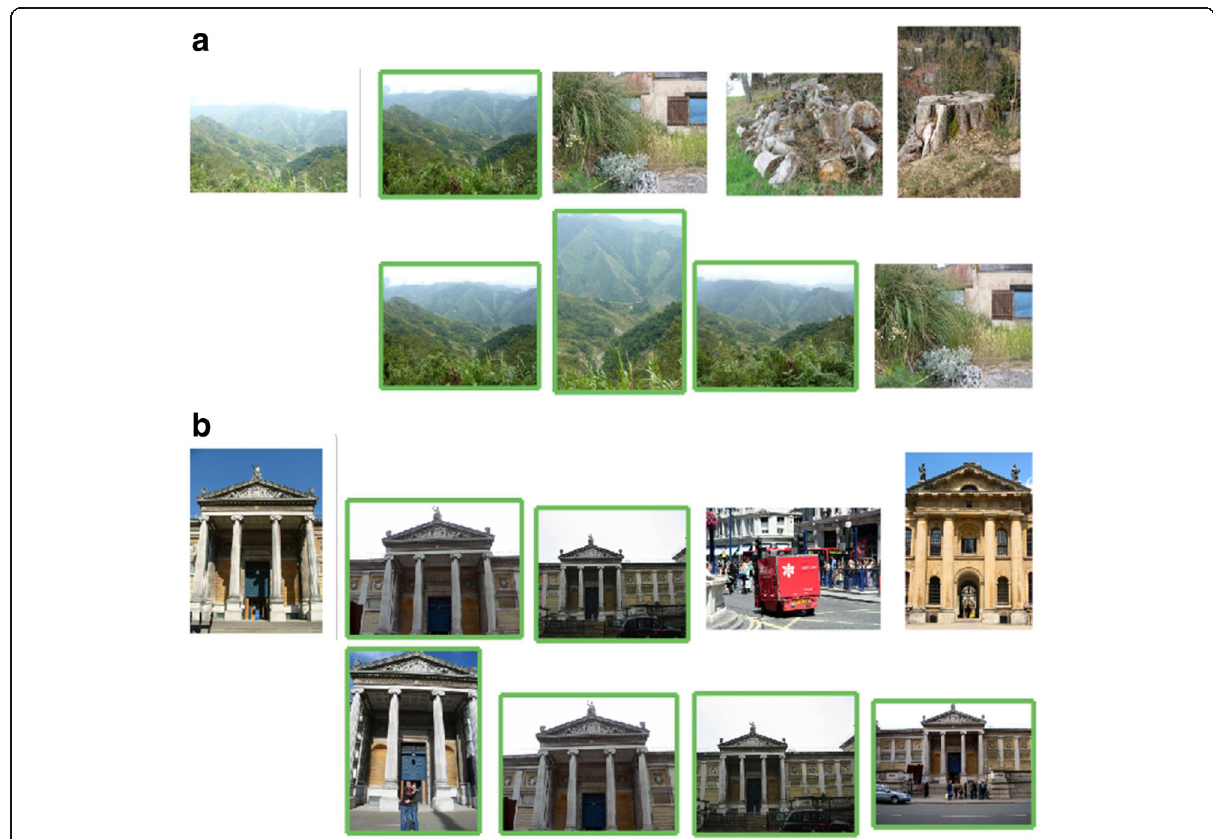
Fig. 1 Examples of images retrieved from ( a ) Holidays and ( b ) Oxford datasets. For each query (left), results obtained by the original VLAD (the first row) and spatial distribution entropy boosted VLAD (SDEVLAD) (the second row) are demonstrated. The green border indicates that the retrieval result meets the ground